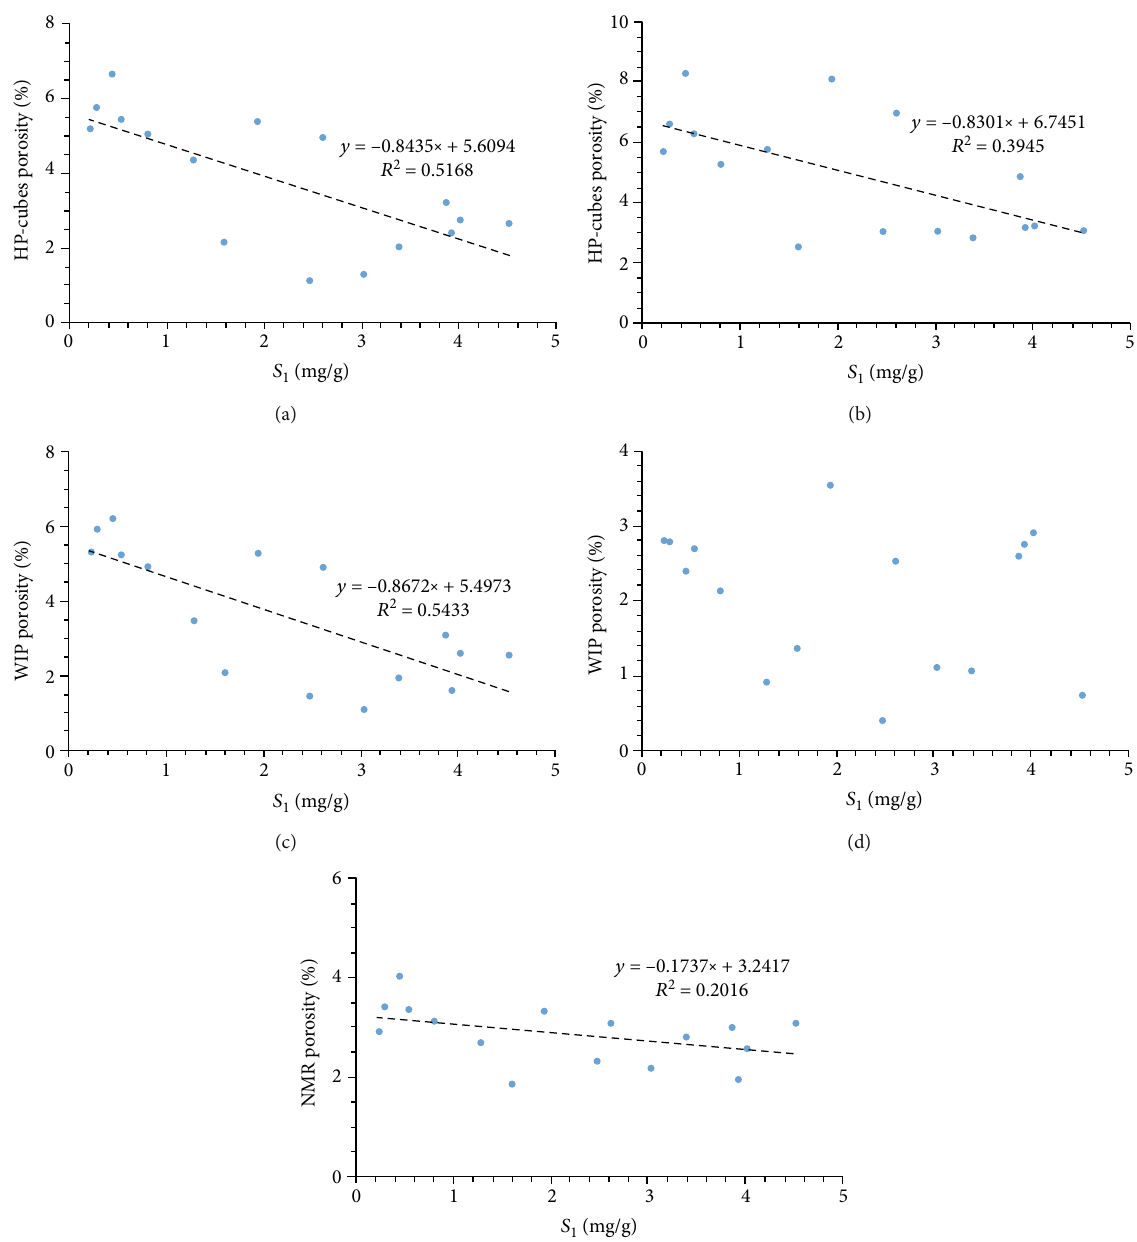
Figure 8: Relationships between S